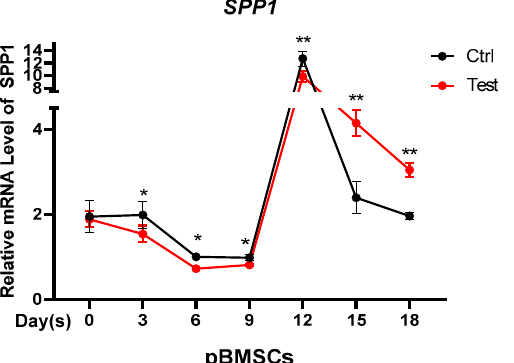
Figure 4. Testosterone regulates the expression of SPP1 . The mRNA expression of SPP1 was detected by PCR at a different stage of pBMSCs differentiation. Ctrl, control group. Test, testosterone group. **, p < 0.01; *, p < 0.05.